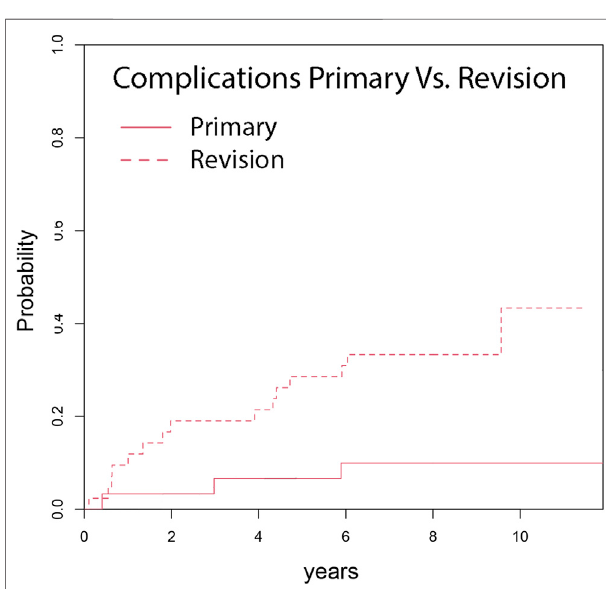
FIGURE 3 | Cumulative incidence shows a signi fi cant differences in occurrence of complications of primary (10.0%) compared to rTKA (33.3%), ( p = 0.011), after minimum 7 years follow up.